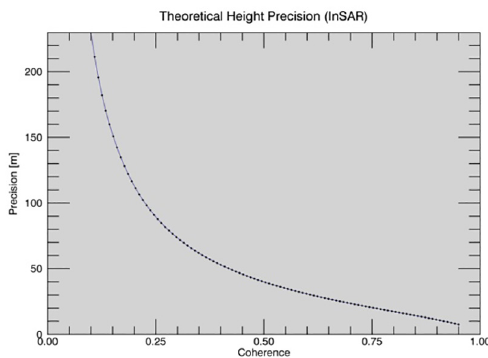
Figure 3. Theoretical height precision graph. X axis is coherence, Y axis is precision (m)